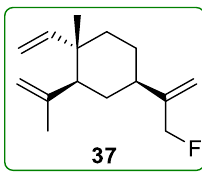
Figure 8. Chemical structures of β -elemene fluorinated derivatives 37 .